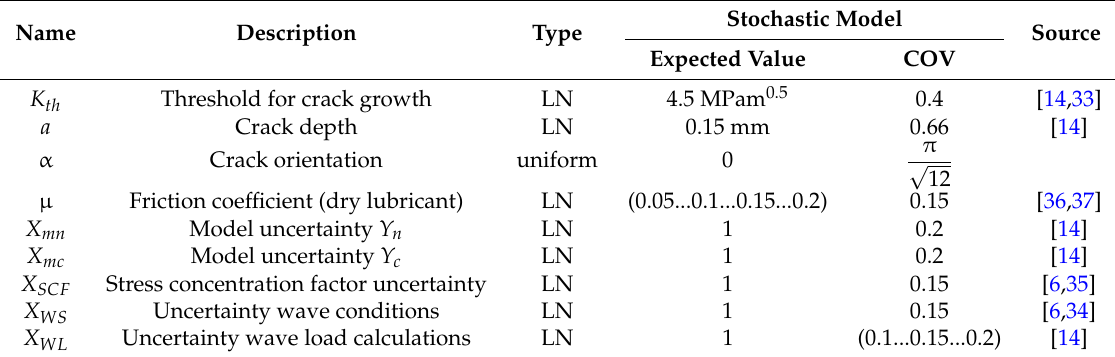
Table 4. Stochastic model for the reliability analysis of plain bearings for the Wavestar device. LN: log normal; COV: coefficient of variation; SCF: stress concentration